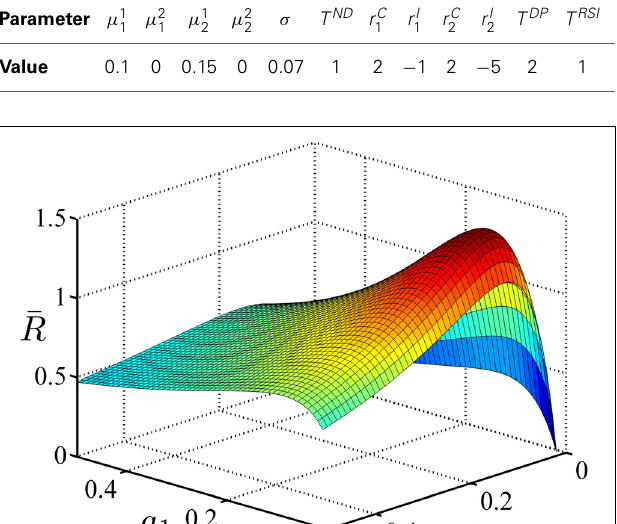
FIGURE 3 | The average reward rate in example 1. In this example, no cue is presented at the beginning of trials and so it is assumed that the subject sets one decision threshold for all trials. In this figure, the average reward rate is plotted as a function of this decision threshold, (denoted as a in the figure), and for different values of the parameter T RSI . Other parameters are given in Table 2 . Table 3 | Task parameters used in the second example.